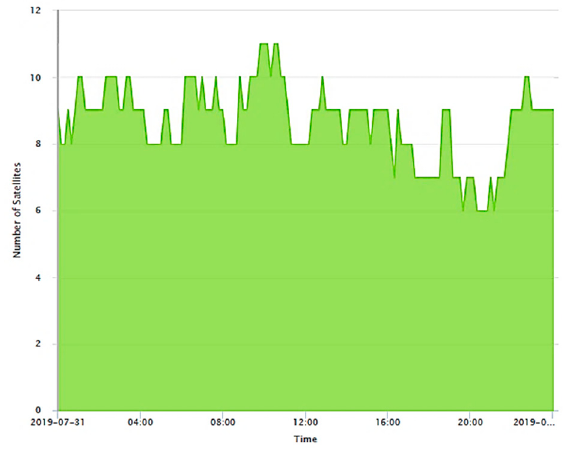
Figure 5. Satellite visibility plot for dataset 2. α α against 0 and the redundancy using the chi-